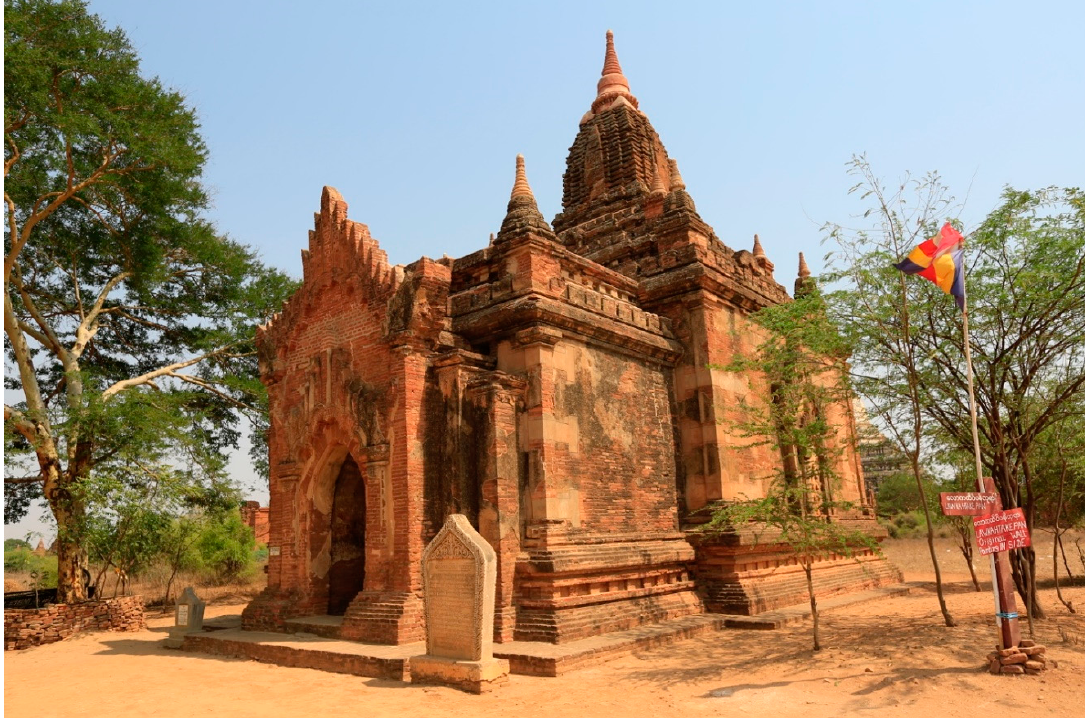
Figure 34. Pagan, Lokahteikpan, 12th century.